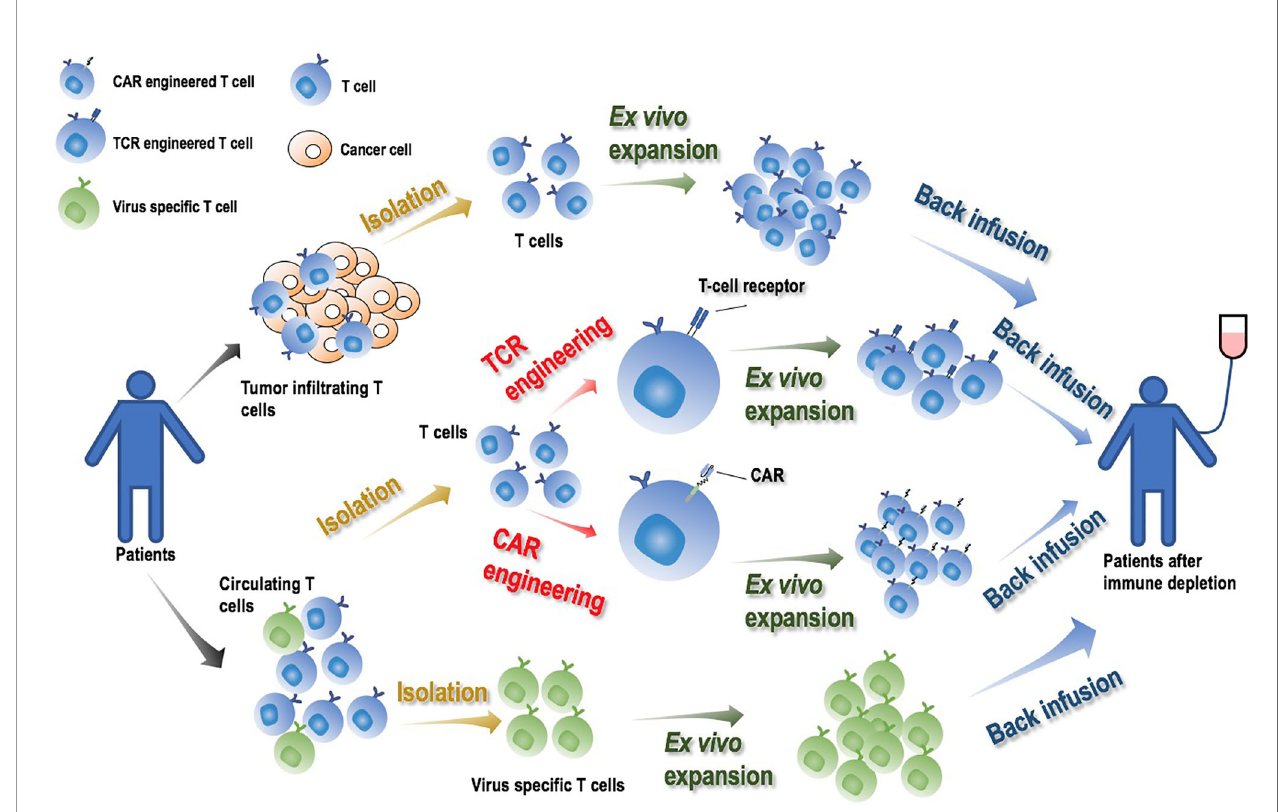
FIGURE 1 | Illustrative diagram on adoptive cell therapy (ACT) and its manufacturing process. By transfusing back one ’ s own genetically engineered T cells or cancer-cognate lymphocytes that identify and attack cancer cells or foreign invasions, ACT activates the immune system and achieves its onco-therapeutic role. Engineered T cells expressing TCRs or CARs, TILs and virus speci fi c T cells expanded ex vivo , are typically used to produce ACT. The manufacturing process is comprised of four major steps: ‘ T cell isolation ’ , ‘ T cell engineering ’ (for TCR or CAR only), ‘ T cell ex vivo expansion ’ , ‘ T cell back infusion ’ . Adjuvant chemo- or radio- therapies are conventionally applied to deplete patients ’ endogenous immune cells prior to ACT infusion to allow infused T cells to fl